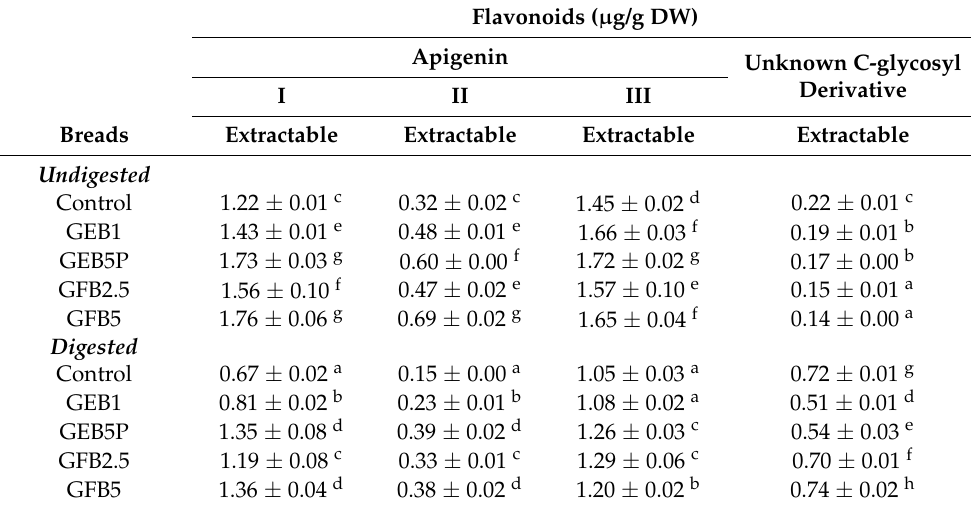
Table 3. Content of extractable flavonoids of both undigested and digested control and bioprocessed